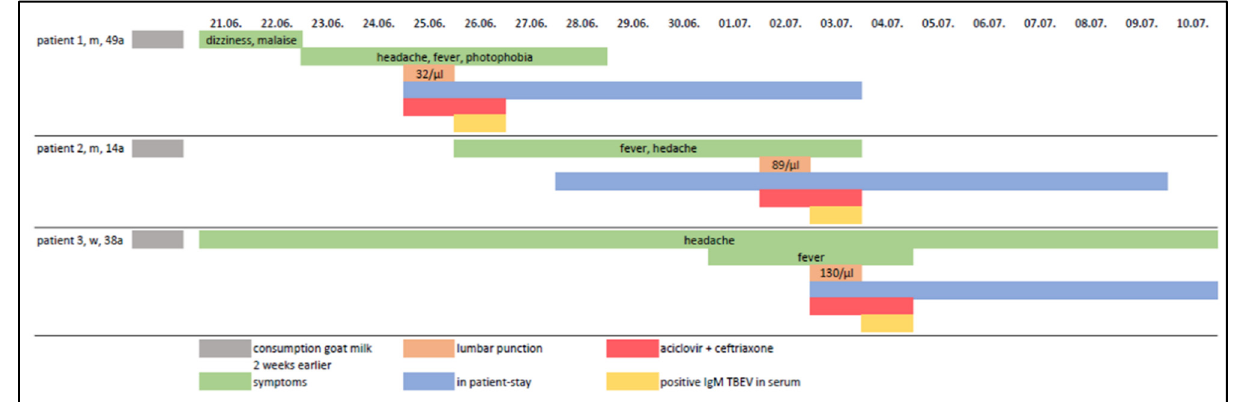
Figure 4. Overview of symptoms, duration of stay, diagnostic results and treatment.